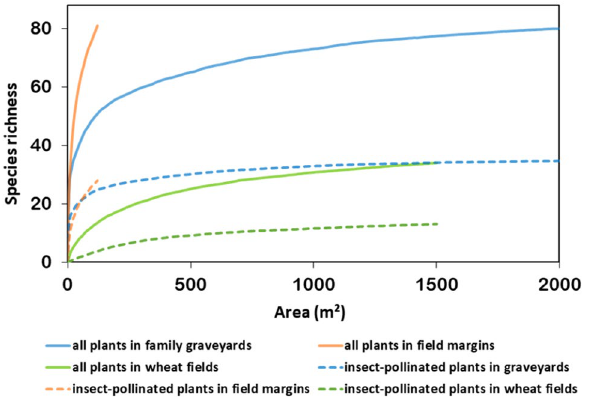
Figure 1. Area-based rarefaction curves comparing plant species richness of the 3 different habitat types. Continuous and dashed lines represent the numbers of ‘overall plants’ and ‘insect-pollinated plants’,